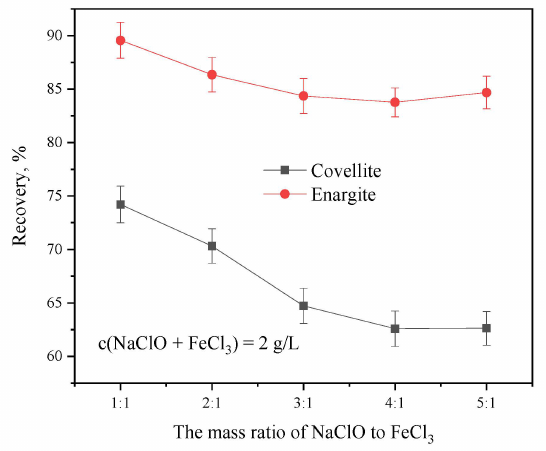
Figure 4. Separation efficiency as a function of the mass ratios of NaClO to FeCl 3 at pH =